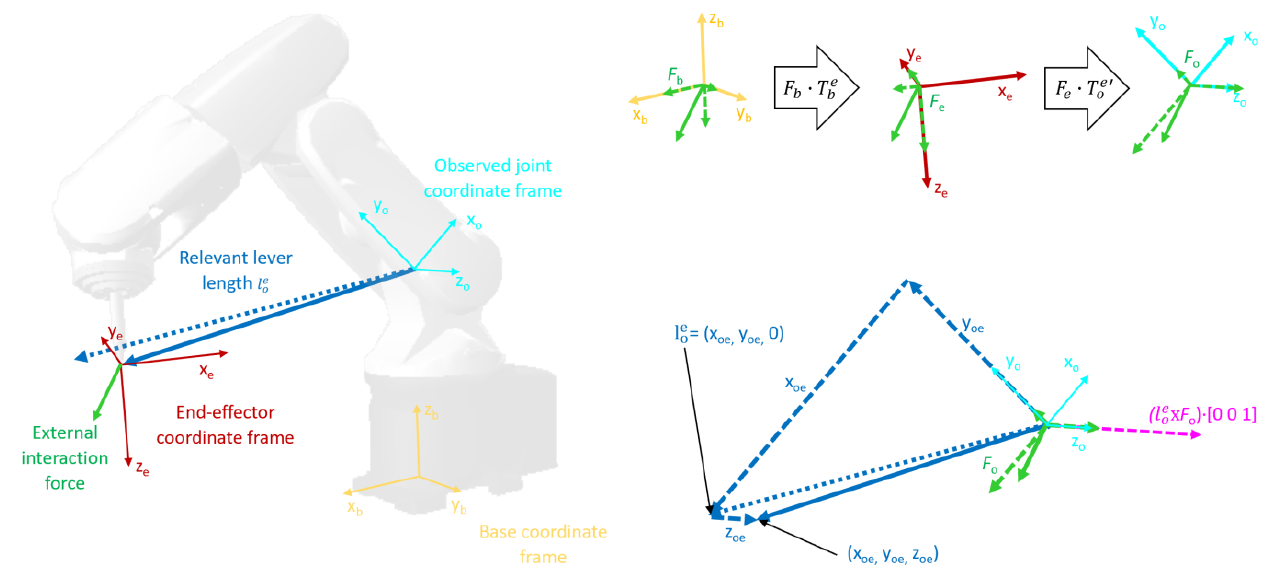
Figure 1. Coordinate frames and transformations. The left section of the figure illustrates the base and tool coordinate frame as well as the coordinate frame of the observed joint together with levers and direction of the external interaction force. The upper right section illustrates the steps of transforming the external force into the coordinate frame of the observed joint. The lower right section of the figure shows the distance between the origins of coordinate frames of the observed joint and the end effector projected onto the x-y plane to determine the relevant lever length. This section of the figure also shows the relevant component of the torque, whose absolute value equates to the equivalent lever length.